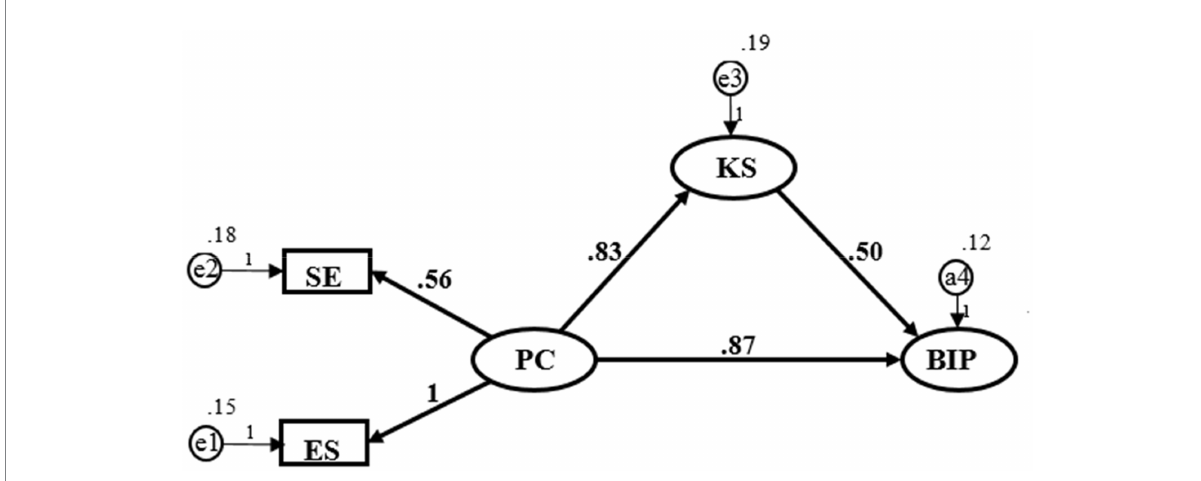
FIGURE 3 Research model path. SE, Self-Efficacy; ES, Emotional Stability; PC, Psychological Capital; KS, Knowledge Sharing; BIP, Breakthrough Innovation